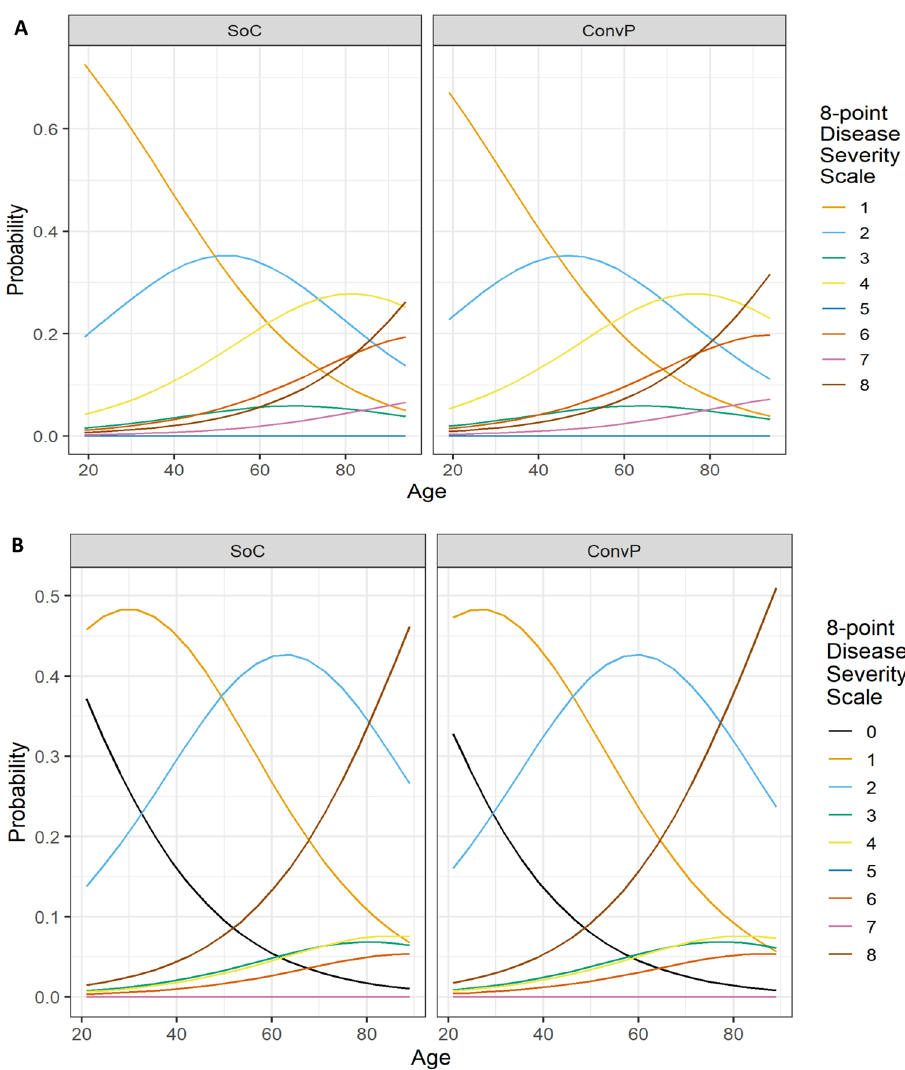
Fig. 1 Predicted probabilities of WHO COVID-19 disease severity score. A Disease severity score after 15 days. B Disease severity score after 30 days. Predicted probabilities of belonging to each outcome category of the WHO COVID-19 8-point Disease Severity Scale over different values of age and per treatment group. The predicted probabilities are based on the proportional ordinal logistic regression model adjusted for age, sex, CRP, and whether a patient was admitted to the intensive care unit at enrollment. The values of these factors are set to the median value (if continuous) or to the most frequent value (if categorical). WHO COVID-19 8-point Disease Severity Scale: 0 = no clinical or virological evidence of infection; 1 = no limitation of activities; 2 = limitation of activities; 3 = hospitalized, no oxygen therapy; 4 = oxygen by mask or nasal prongs; 5 = non-invasive ventilation or high- fl ow oxygen; 6 = intubation and mechanical ventilation; 7 = ventilation + additional organ support = vasopressors, renal replacing therapy, extracorporeal membrane oxygenation (ECMO); 8 =